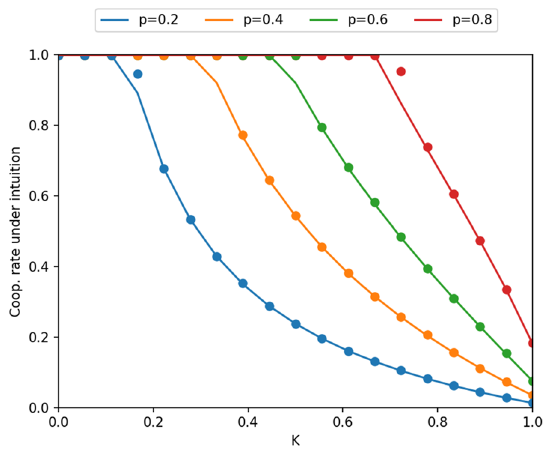
Figure 7. Solid lines are the theoretical frequencies obtained through the long-run Markov chain analysis. Dots are the empirical frequencies obtained through simulations with 500 agents, 5000 time periods, and A = 1